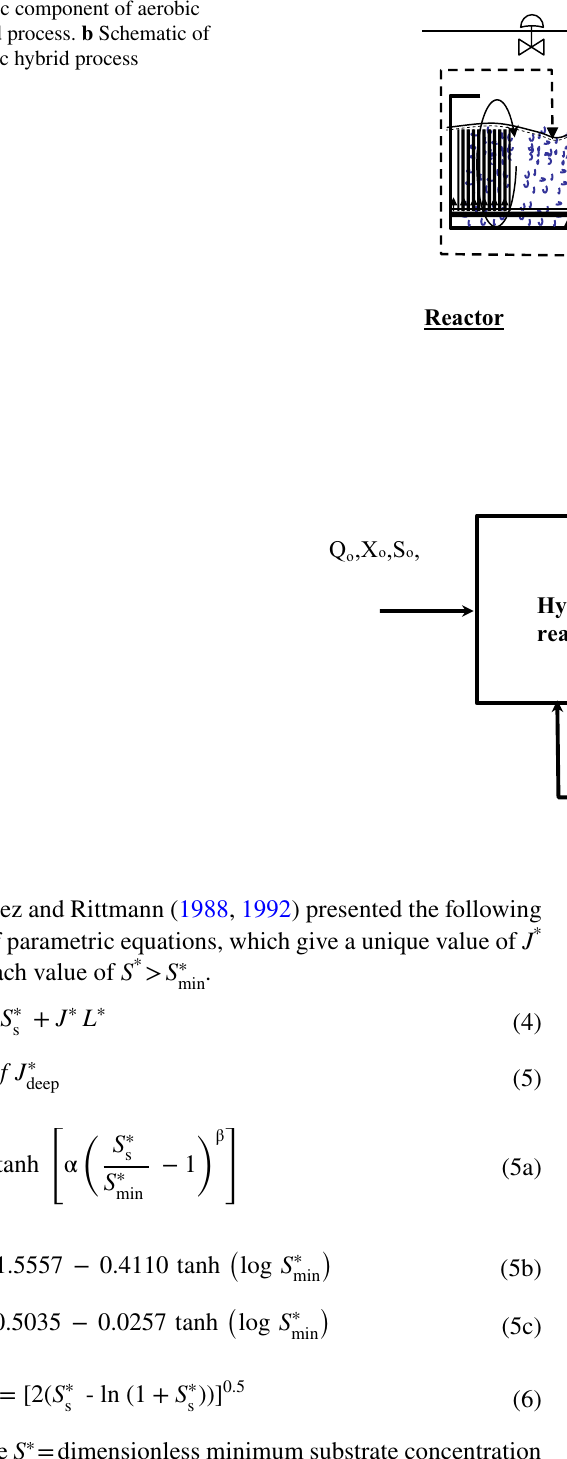
Fig. 1 Aerobic hybrid process a Basic component of aerobic hybrid process. b Schematic of aerobic hybrid